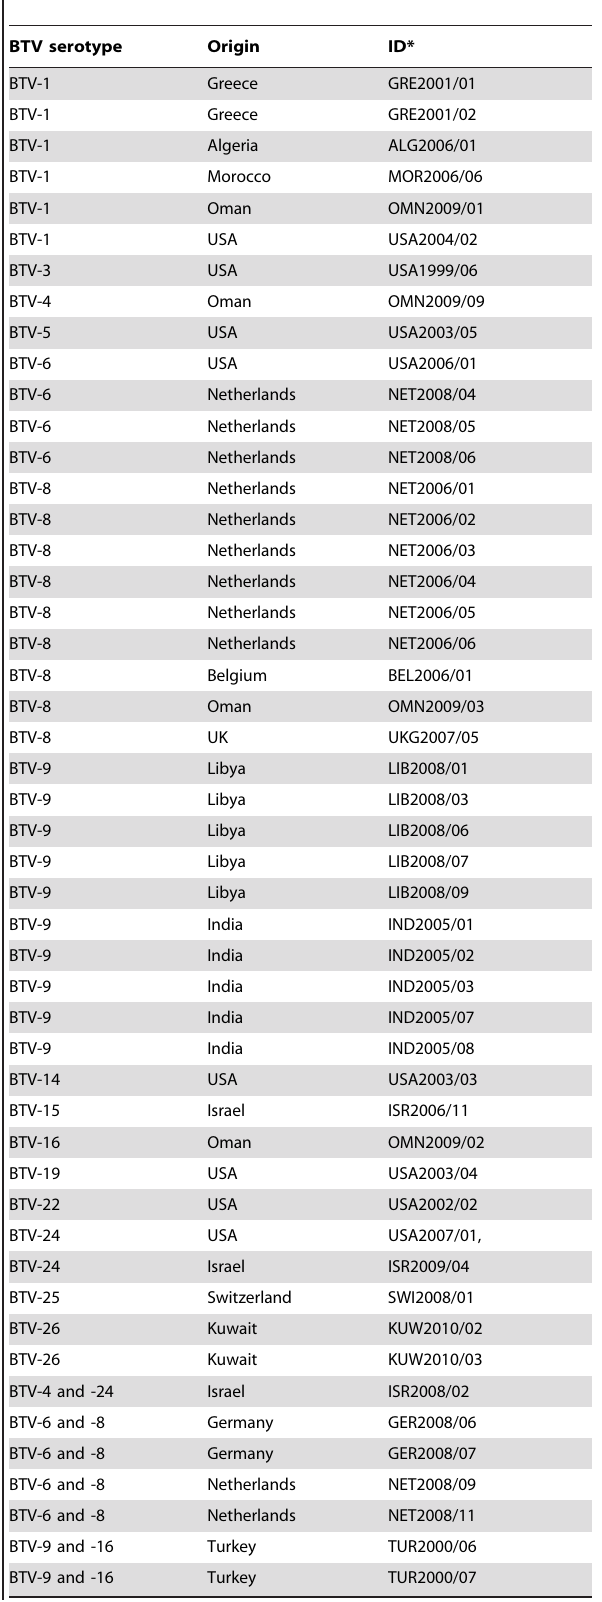
Table 1. Field isolates of BTV typed using Seg-2 based serotype-specific RTPCR